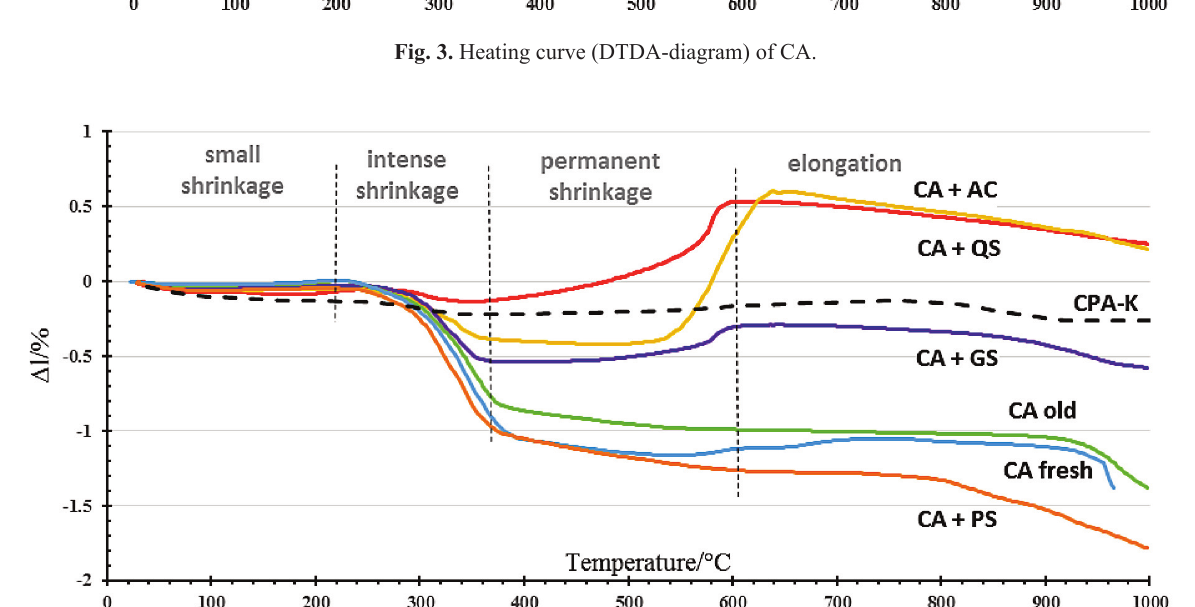
Fig. 4. Shrinkage-expansion curves of CA-based